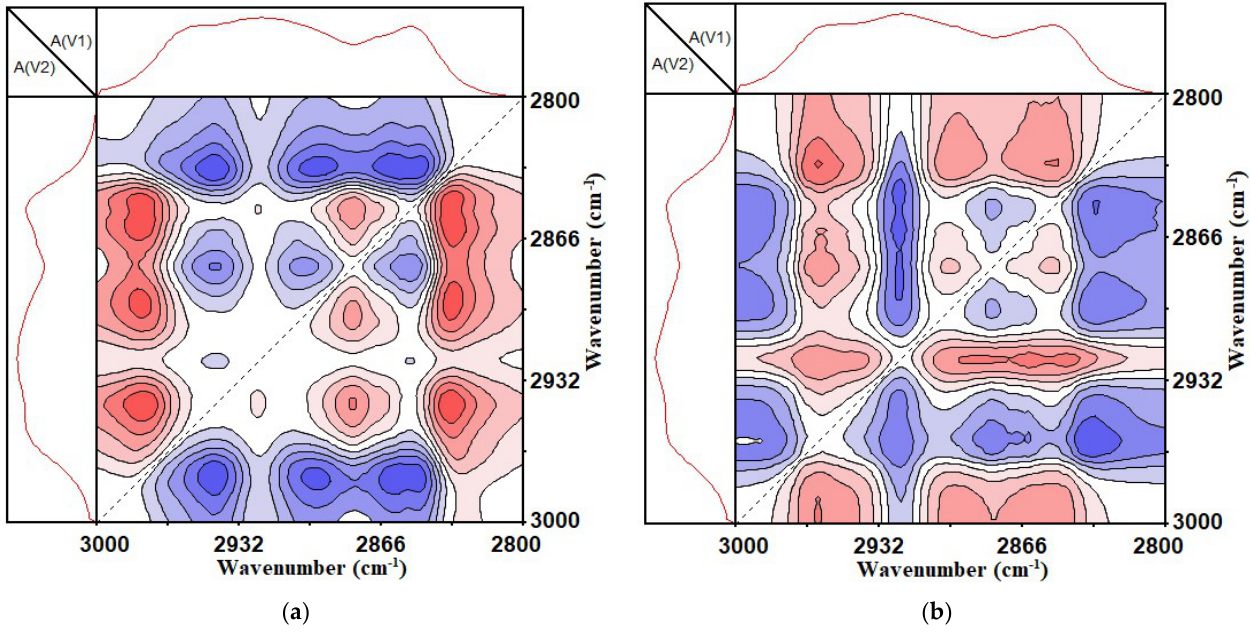
Figure 10. Two-dimensional asynchronous infrared correlation spectrum of 3000~2800 cm −1 . ( a ) SBS-modified asphalt binder; ( b ) SBS + 1% CNTs composite-modified asphalt binder.